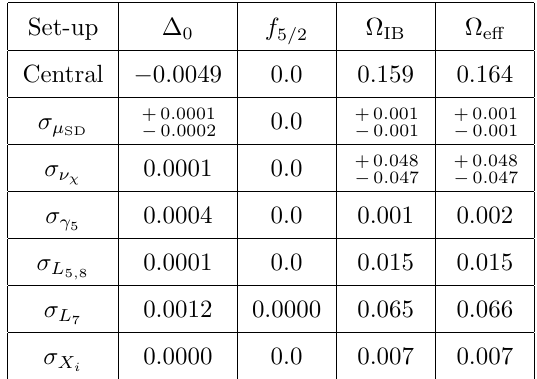
Table 13 . NLO central values for (cid:11) = 0 and their parametric errors.